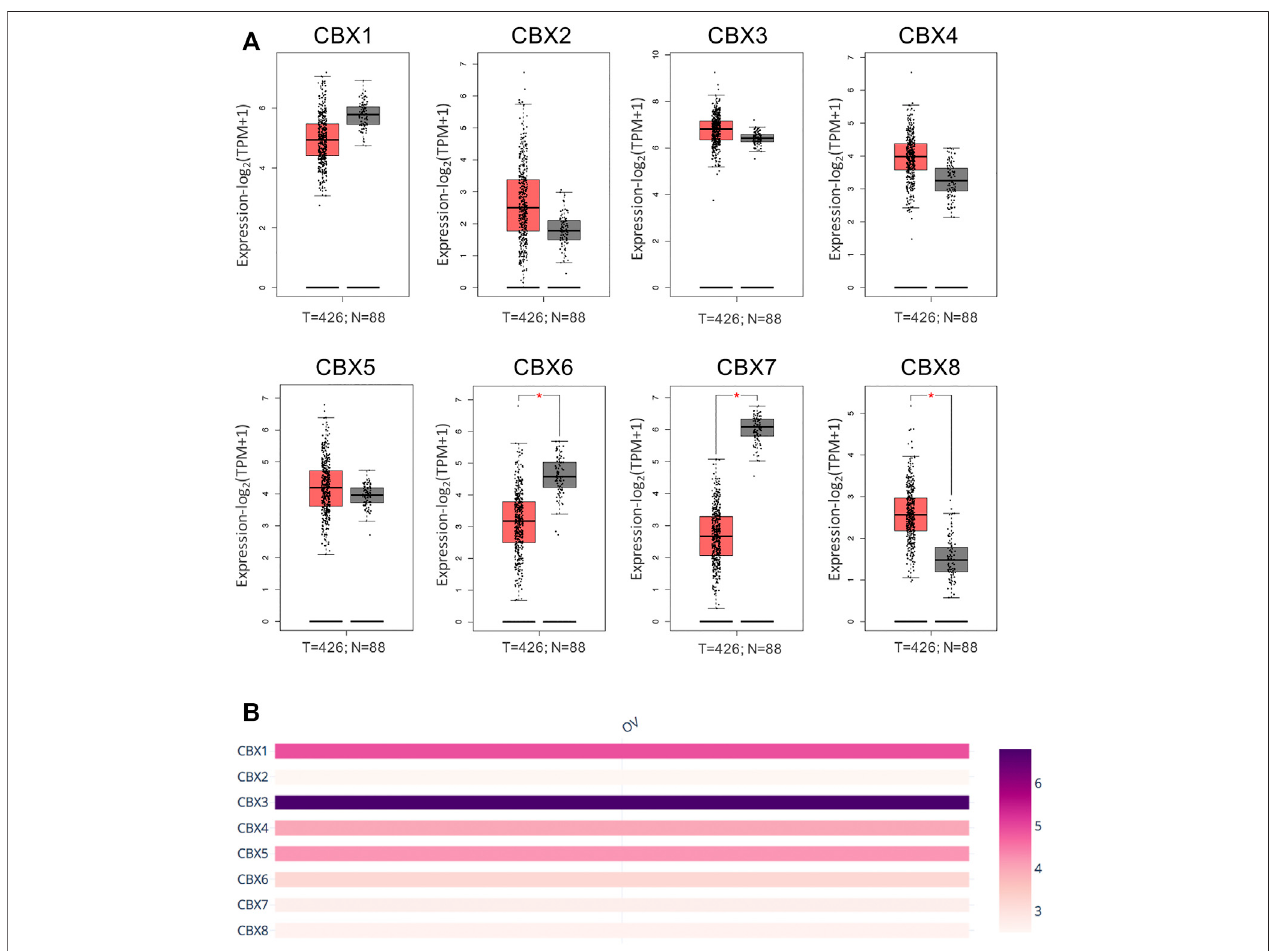
FIGURE1 | mRNA expression levels of theCBXs familymembersin OVtissuesand normal ovarian tissues. (A) The mRNA expression pro fi les were obtained from the GEPIA2 databases. T represented ovarian cancer tissues; N represented normal ovarian tissues. * p < 0.05. (B) The relative expression of the CBXs family members in